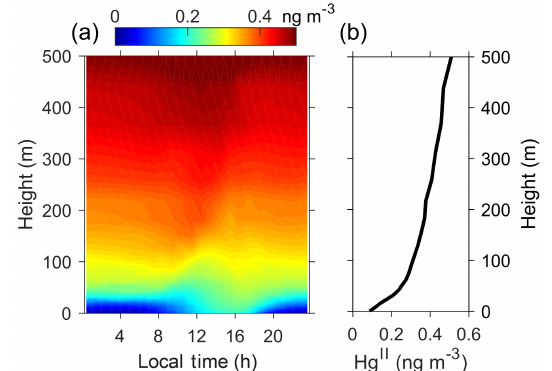
Figure 6. Summertime diurnal and vertical profiles of atmospheric Hg II concentrations. Panel (a) shows both diurnal and vertical dis- tributions, and (b) only shows the average vertical profile. Model results from the BR_HH_14d scenario are shown.